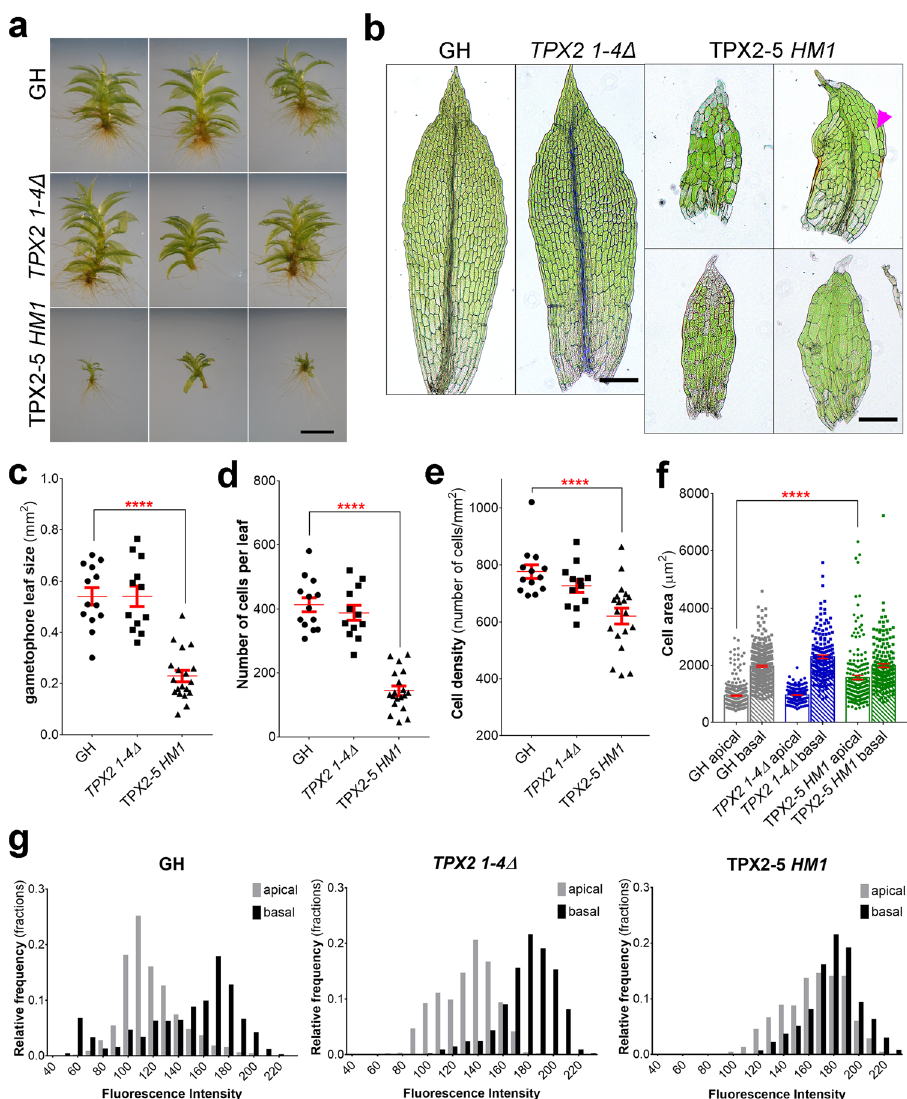
Fig. 3 Abnormal gametophore and leaf development in the TPX2-5 HM1 mutant. a Representative images of gametophores after 4 weeks of culture of GH (control), TPX2 1-4 Δ , and TPX2-5 HM1 lines. Brightness/contrast have been linearly adjusted. An extended version is presented in Supplementary Fig. 3. Experiment was repeated three times with similar results. Bar, 2 mm. b Representative images of gametophore leaves of GH, TPX2 1-4 Δ , and TPX2-5 HM1 lines. The magenta arrowhead indicates abnormally large cell occasionally observed in the TPX2-5 HM1 line. Bar, 200 µ m. c Gametophore leaf size (mm 2 ), d number of cells per leaf, e cell density (number of cells per mm 2 ), f cell area ( µ m 2 ) of the apical and basal sides of the gametophore, measured in gametophore leaves collected after 3 weeks of culture with n = 13, 12, and 19 for GH, TPX2 1-4 Δ , and TPX2-5 HM1 lines, respectively (mean ± SEM, **** p = 0.0001 by one way ANOVA with Dunnett ’ s multiple comparison test against GH). Apical and basal sides correspond to 1/3 of leaf length at the tip and at the base, respectively. g Quanti fi cation of the nuclear DNA content in the interphase nucleus of gametophore leaf cells (from apical and basal sides). DNA amounts were measured as fl uorescence intensity (arbitrary unit) of the DAPI-stained nuclei per cell without background subtraction. GH and TPX2 1-4 Δ lines have two ploidy peaks corresponding to apical and basal sides of gametophore leaves; In the TPX2-5 HM1 line, the difference in ploidy is less